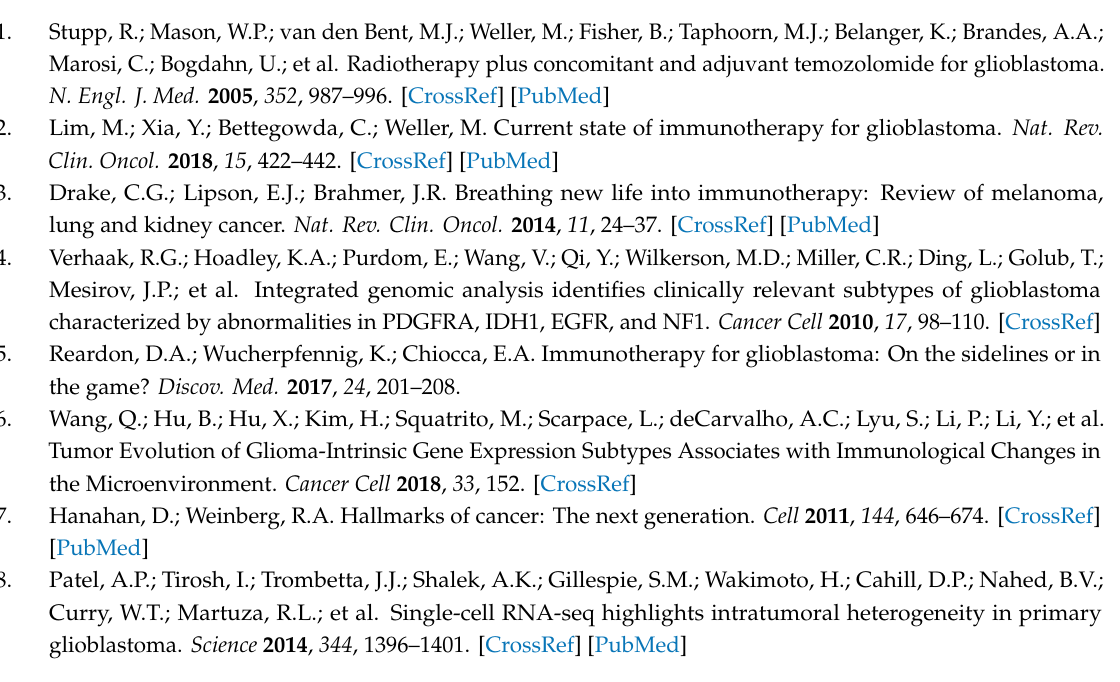
Supplementary Materials: The following are available online at http: // www.mdpi.com / 2072-6694 / 12 / 5 / 1213 / s1, supplementary Materials and Methods and Database Information, Figure S1: Supplementary to Figure 1, Figure S2: Supplementary to Figure 2, Figure S3: Supplementary to Figure 3, Figure S4: Supplementary to Figure 4, Table S1: List of genes identified as significantly deregulated between CT and PZ in these features of glioblastoma, Table S2: ( A ) Gene ontology enrichment analysis based on hypergeometric distribution followed by FDR correction, showing the top three most enriched biologic functional categories of genes up- or downregulated in PN vs. CT. ( B ) The promoter sequences of the genes up-regulated and down-regulated compared with the other genes in the genome in terms of transcription factor (TF) binding motifs within 300 bp upstream of transcription start. Table S3: Summary of genes deregulated in PN vs. CT, grouped by functional categories defined by high-level GO